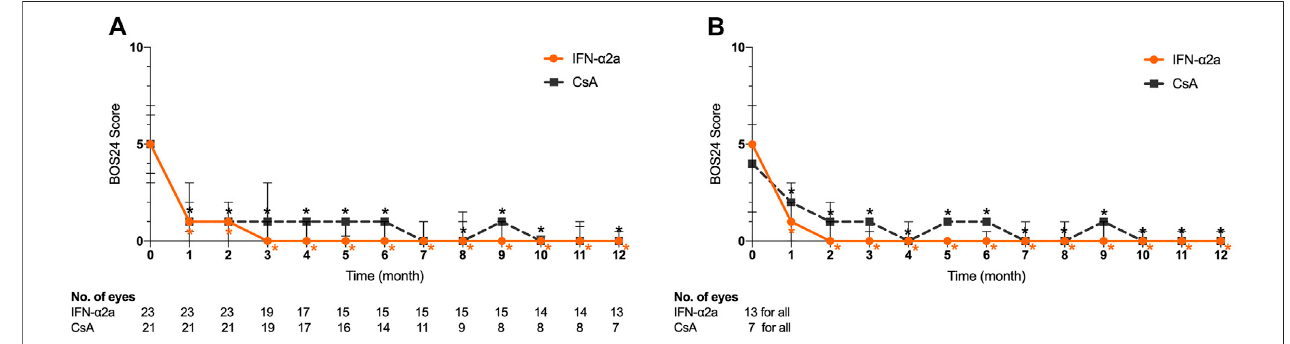
FIGURE 3 | Changes in Behçet ’ s disease ocular attack score 24 (BOS24) for eyes treated with interferon alpha-2a (IFN- α 2a) and cyclosporine-A (CsA). (A) Changes in median BOS24 score for all eyes treated with IFN- α 2a (n (cid:1) 23) and CsA (n (cid:1) 21) during the 12-month follow-up. (B) Changes in BOS24 score for eyes with complete remission treated with IFN- α 2a (n (cid:1) 13) and CsA (n (cid:1) 7) during the 12-month follow-up. Data are shown as the median and IQR. *: p <